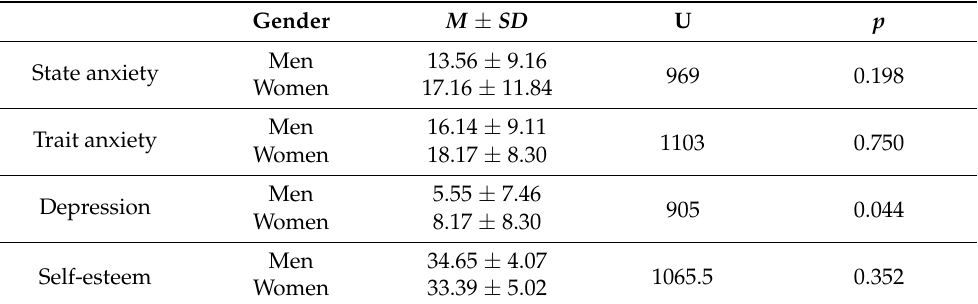
Table 5. Results for the differences in the sample of speleologists according to